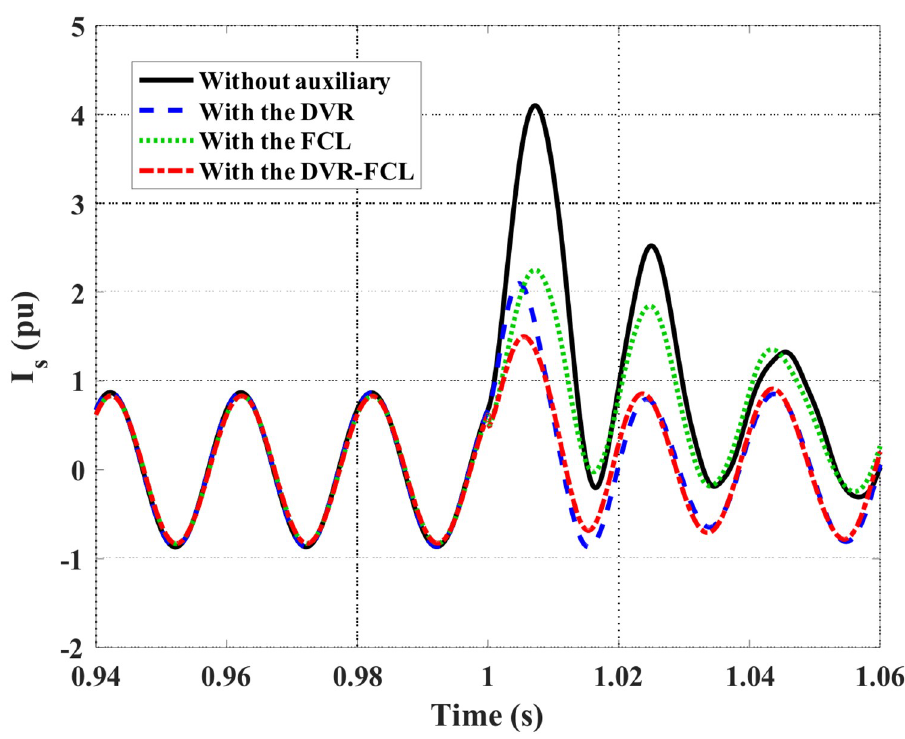
Fig 7. Stator current of the DFIG subject to the symmetrical fault.